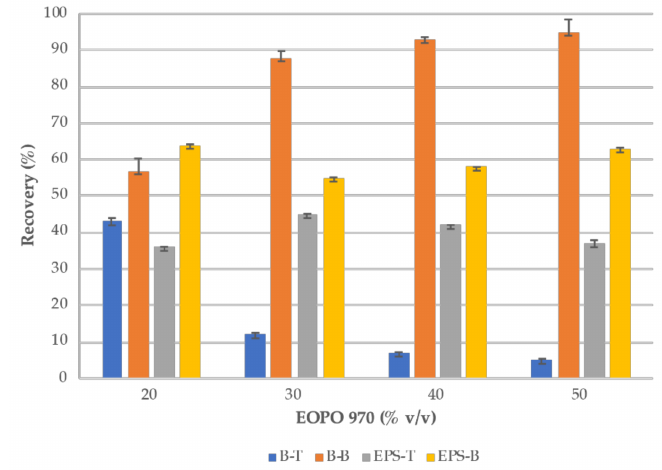
Figure 5. Rhodotorula mucilaginosa UANL-001L biomass (B) and exopolysaccharide (EPS) recovery in top (T) and bottom phase (B) of extractive fermentation with EOPO 970 at